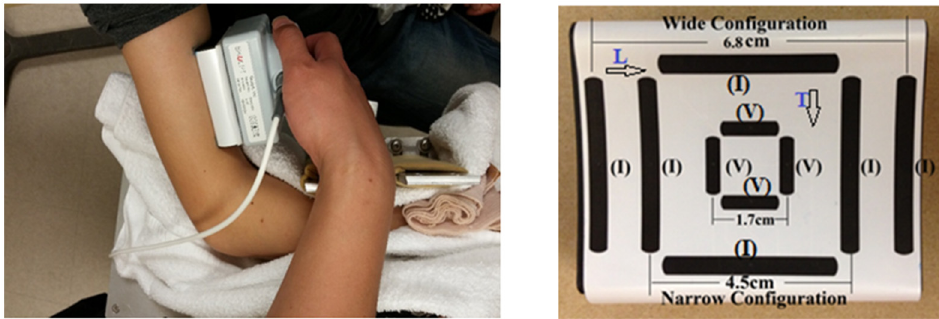
Fig 1. Position of the probe anpd a close up of the handheld electrode array configurations. (I) means current electrodes; (V) means voltage electrodes; L with arrow means the longitudinal direction; T with arrow means the transverse